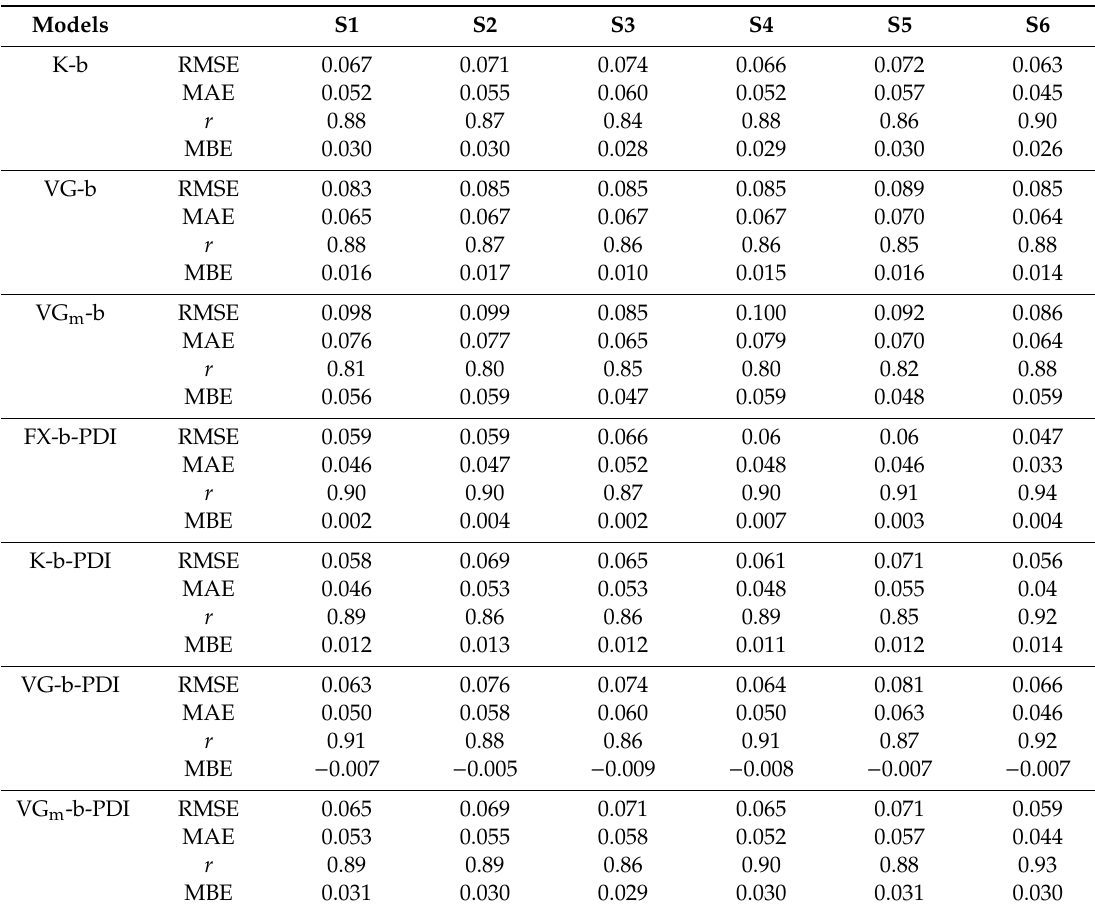
Table 5. Performance evaluation of the bimodal and bimodal-PDI parametric PTFs for all modeling scenarios